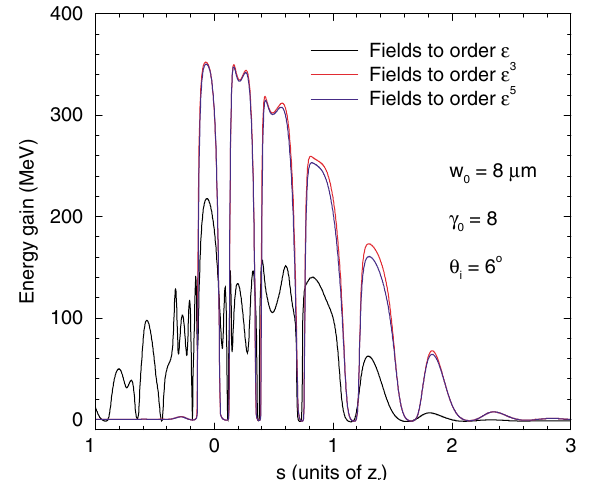
FIG. 9. (Color) Variation of the energy gain with s when contributions to the fields of order up to (cid:1) N , N (cid:3) 1 , 3, and 5, are taken into account. Electron initial position is [ x (cid:6) tan (cid:6) (cid:3) (cid:2) 3 mm ] and it is injected into the point ; 0 ; z z i 0 0 (0,0, s ). The laser wavelength is (cid:20) (cid:3) 1 (cid:28) m , and its output power is P (cid:3) 1 PW